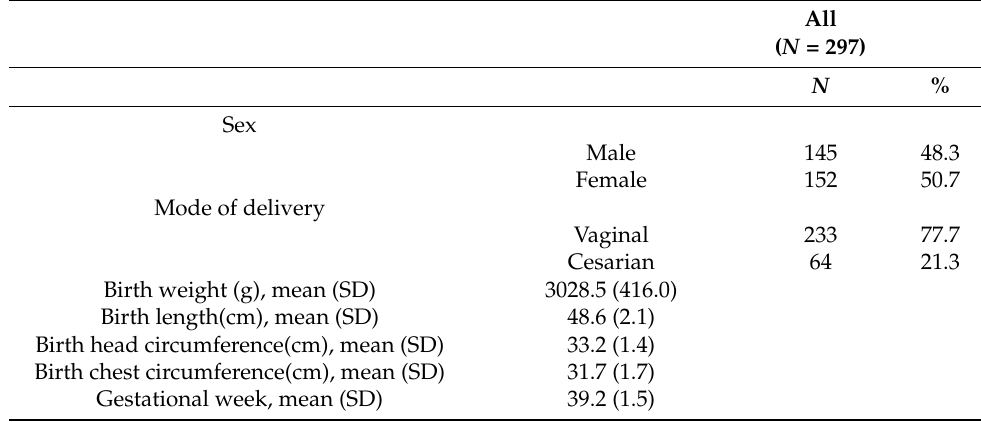
Table 2. The characteristics of the infants included in this